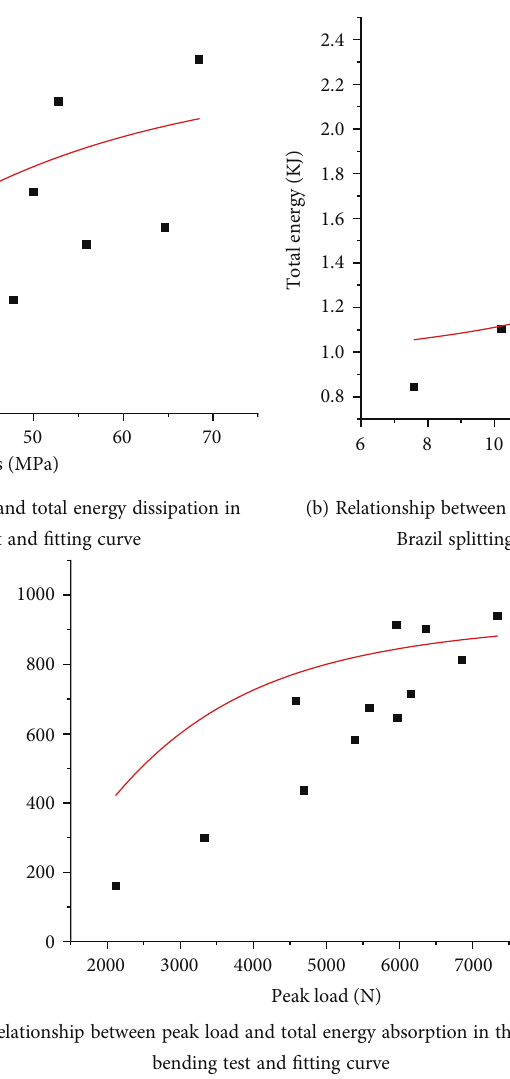
Figure 18: Fitting relationship between peak load and total absorbed energy in di ff erent